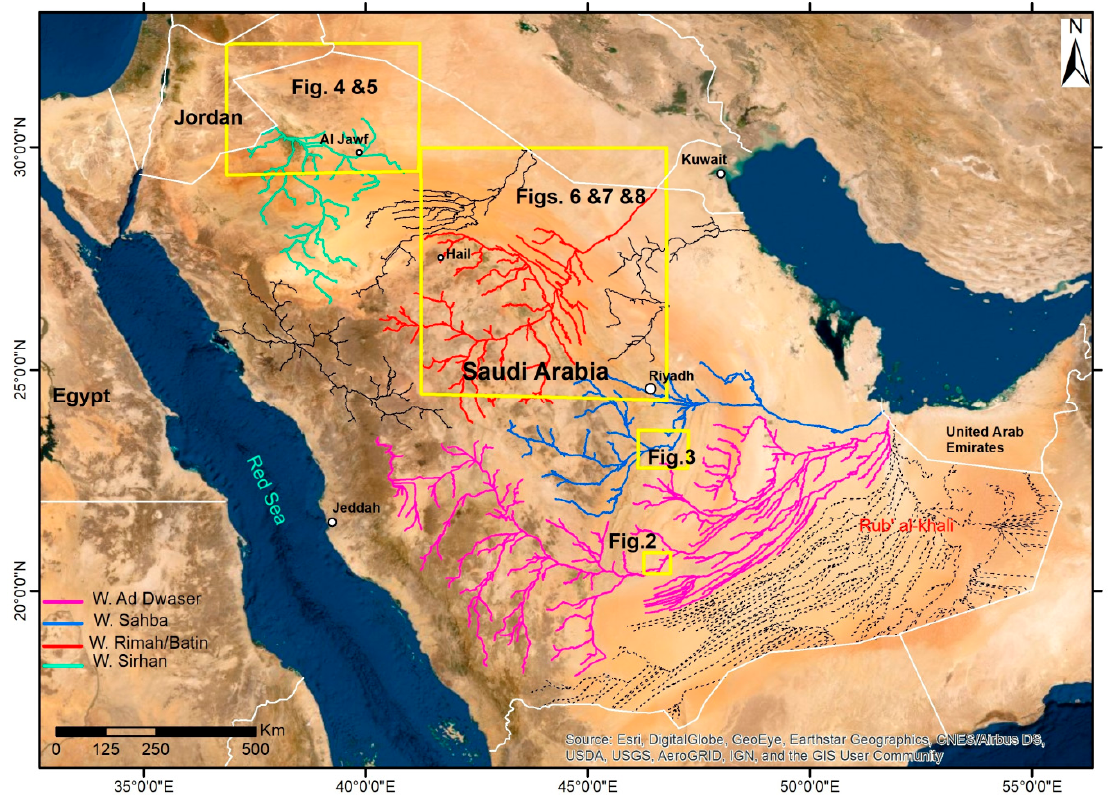
Figure 1. Locations of the study regions discussed in this paper, marked in yellow rectangles, and overlaid on the satellite base map. The areas studied are Wadi ad-Dawasir, Wadi Sahba, Wadi Rimah/Batin, and Wadi Sirhan.